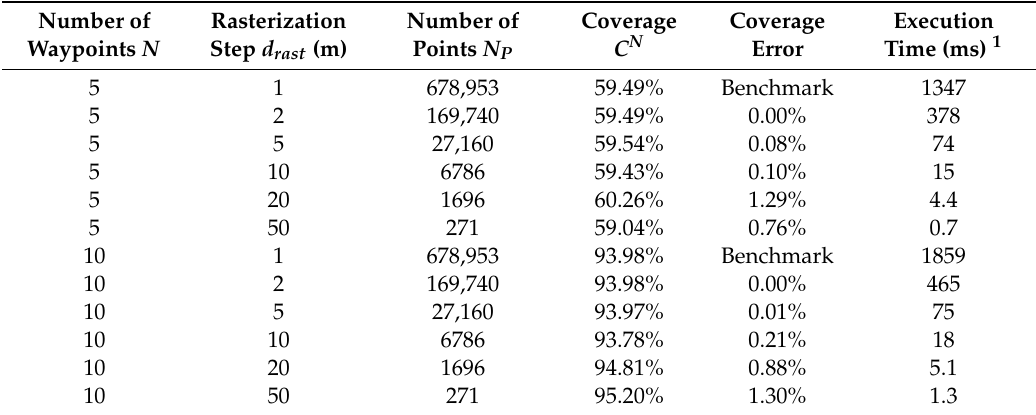
Table 1. Experiments with the solution evaluation via the original algorithm.